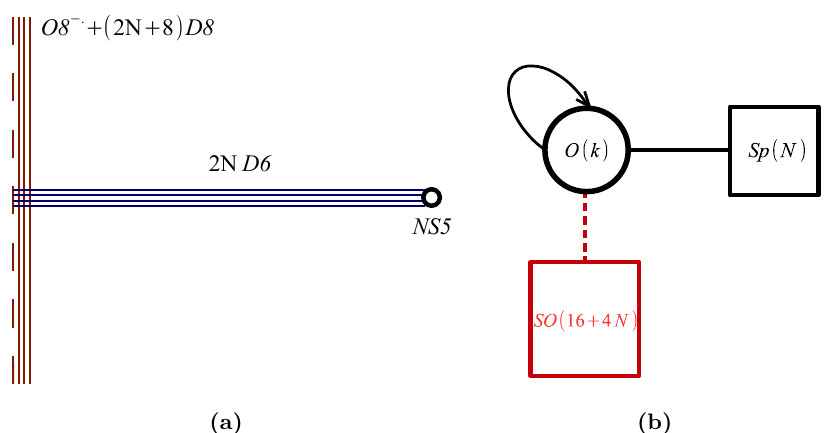
Figure 14. (a): type IIA brane engineering of the 1 6d SCFTs, and (b): 2d (0,4) quiver Sp( N ) theory for k BPS strings of the SCFT. The dashed and continuous lines symbolize respectively bifundamental Fermi and hypermultiplets; the gauge node supports an O ( k ) adjoint vector multiplet and a hypermultiplet in the symmetric representation of O ( k ) represented by the